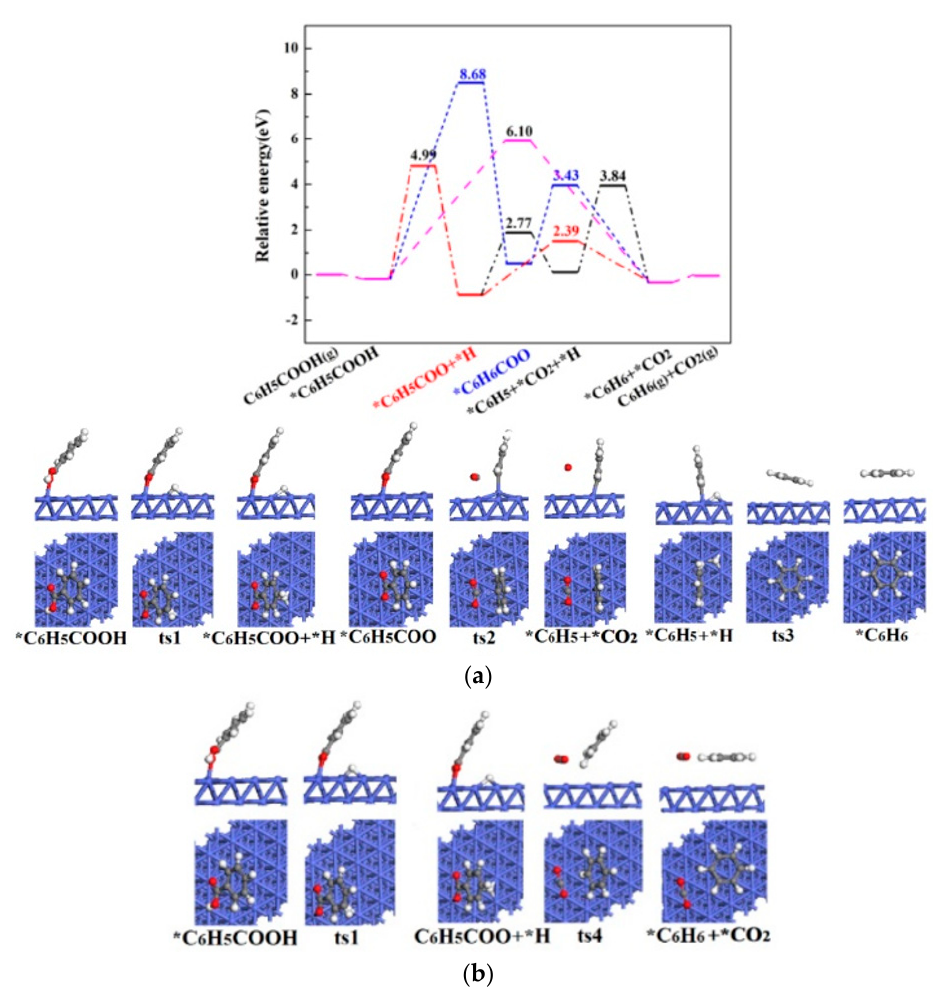
Figure 6. The potential energy diagrams (Purple line: C 6 H 5 COOH(g) → *C 6 H 5 COOH → *C 6 H 6 + *CO 2 → C 6 H 6 (g)+ CO 2 (g); Blue line: C 6 H 5 COOH(g) → *C 6 H 5 COOH → *C 6 H 6 COO → *C 6 H 6 + *CO 2 → C 6 H 6 (g)+ CO 2 (g); Red line: C 6 H 5 COOH(g) → *C 6 H 5 COOH → *C 6 H 5 COO + *H → *C 6 H 6 + *CO 2 → C 6 H 6 (g)+ CO 2 (g); Black line: C 6 H 5 COOH(g) → *C 6 H 5 COOH → *C 6 H 5 COO + *H → *C 6 H 5 + *CO 2